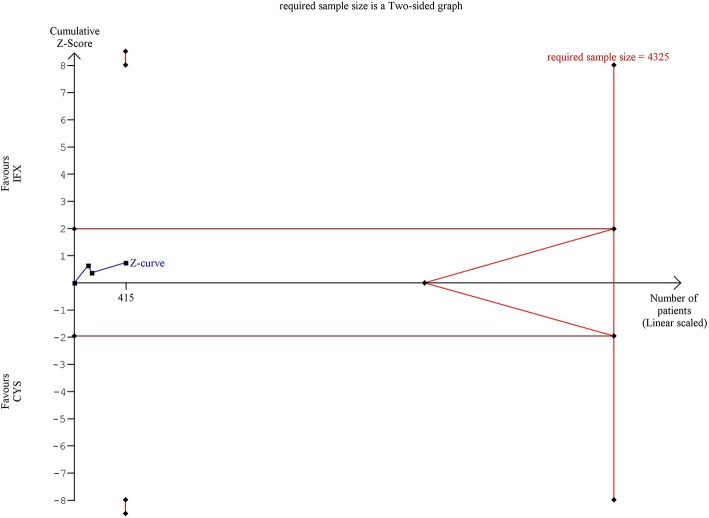
Results of the trial sequential analysis of the risks of serious adverse events. The required sample size was calculated using α = 0.05 (two-sided) and ß = 0.02 (power of 80%). The cumulative Z-curve (blue) did not cross the monitoring boundary (red) and not reached the required information size (4,325 patients). There is insufficient information about the evidence of significance.